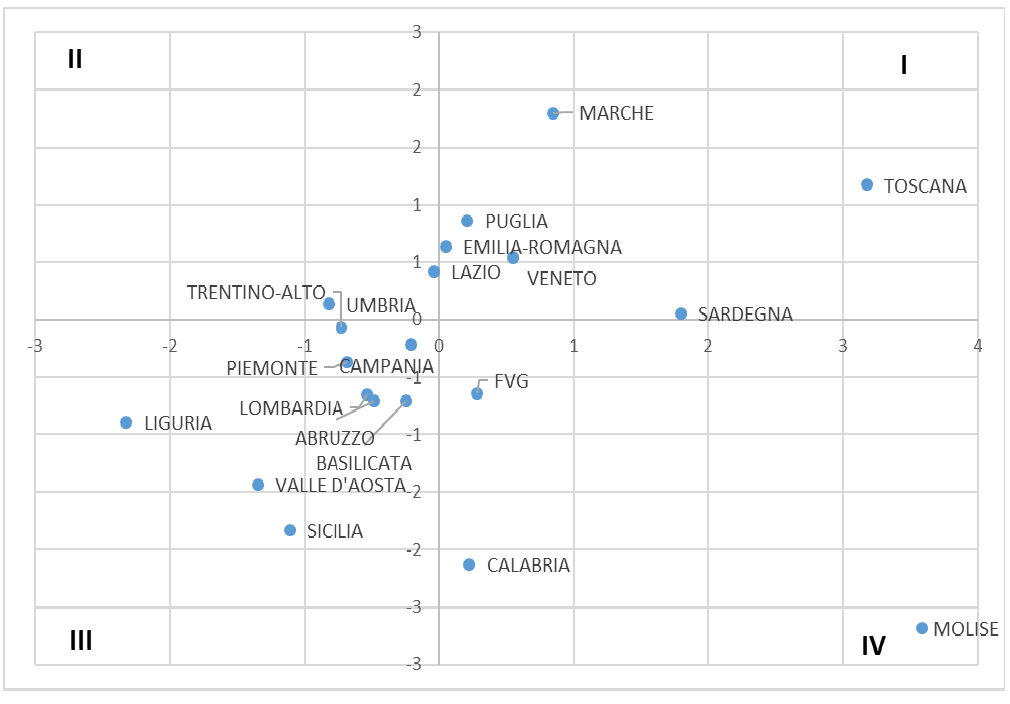
Figure 2: Synthesis of the Relationship Between the Measure of Resistance and